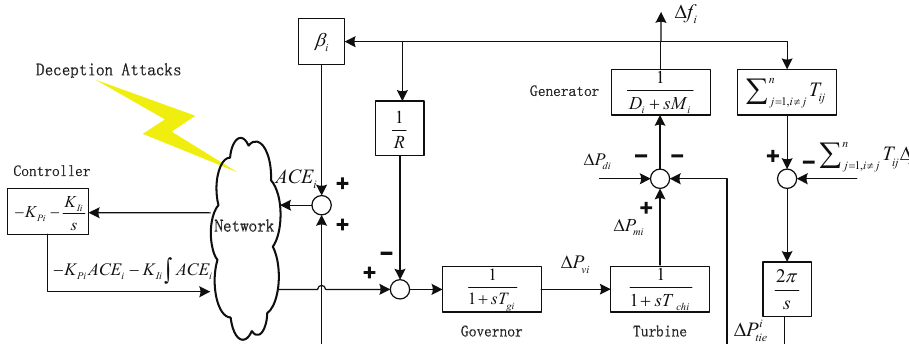
Figure 1. The framework of network-based LFC of i th area power